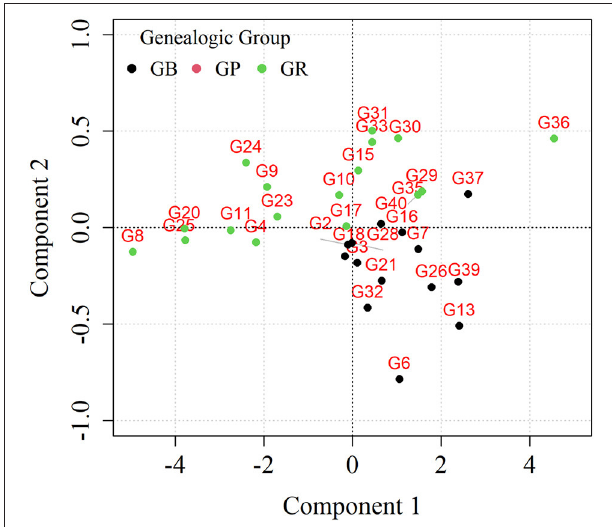
FIGURE 5 | Graph of the PLS-DA scores of two components for the sensory attributes with the classifications of the genealogical groups. ( ) GB-Bourbon Group, ( ) GR—Resistant Group ( ) GP—Paraíso Germplasm.